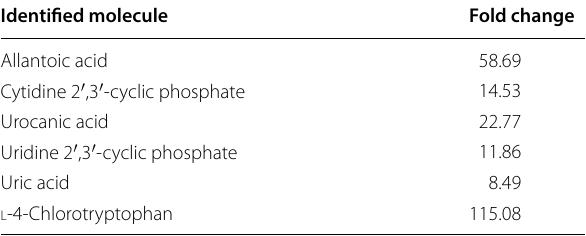
Table 1 Shortlisted extracellular metabolites showing significant fold change in micro-aerobic culture compared to aerobic culture by LC–MS analysis in positive ionization